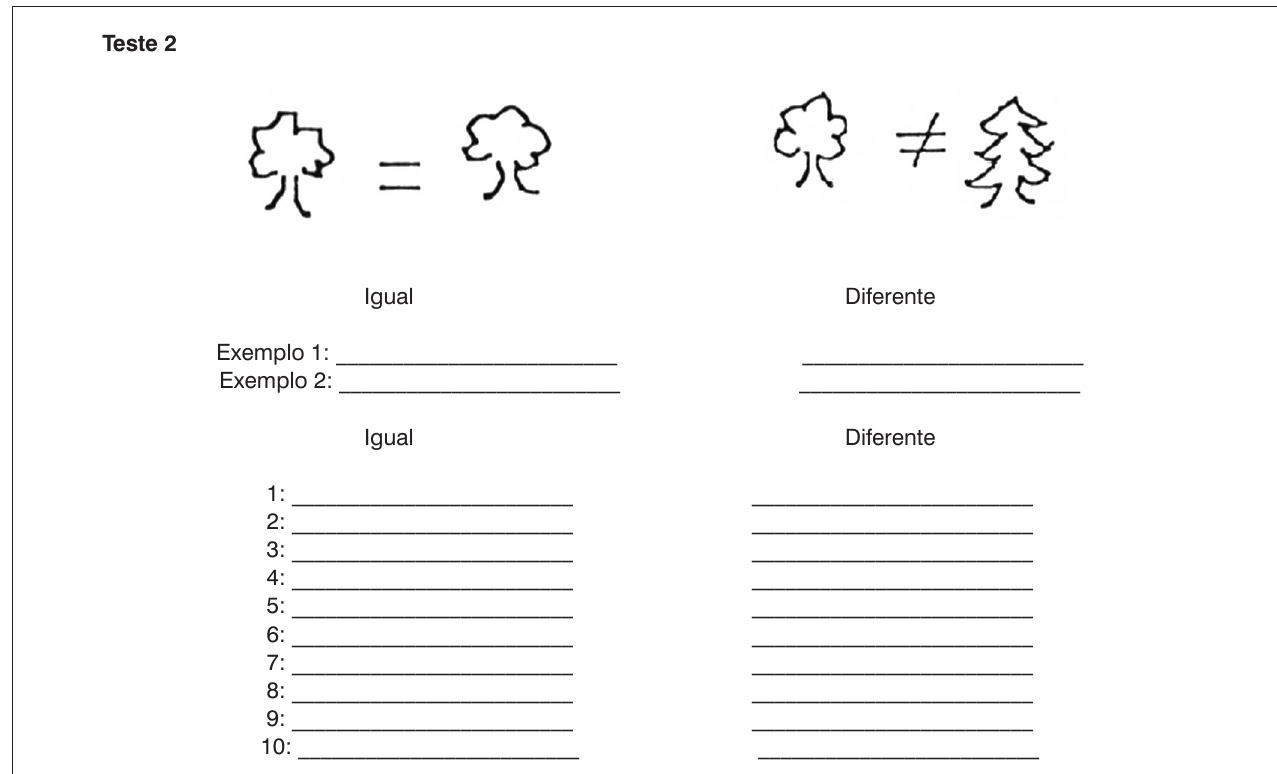
Figura 4. Exemplo da folha de respostas - teste